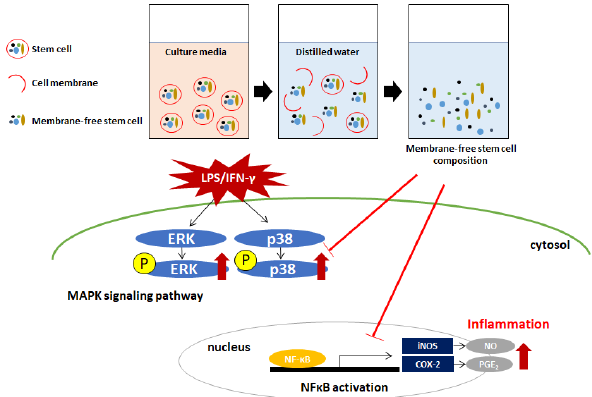
Figure 6. Predicted mechanism on the effect of MFSC-Ex in LPS/IFN- γ -induced RAW 264.7 macrophage cells.